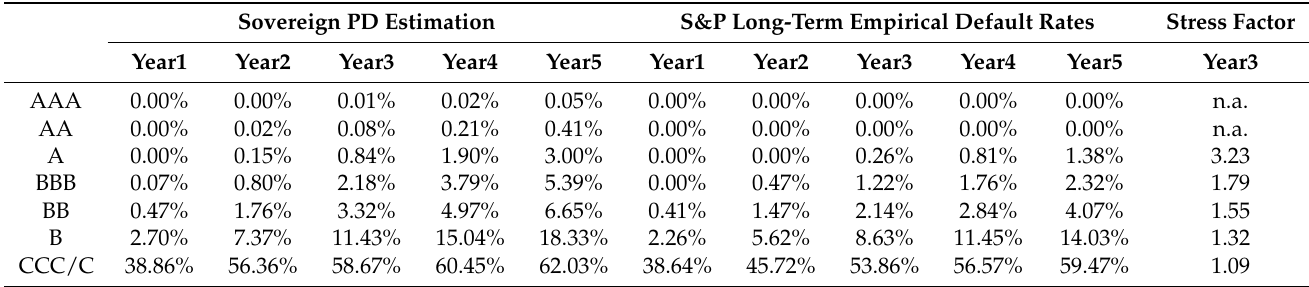
Table 5. Estimated cumulated sovereign PDs and S&P empirical default rates. Sovereign PD